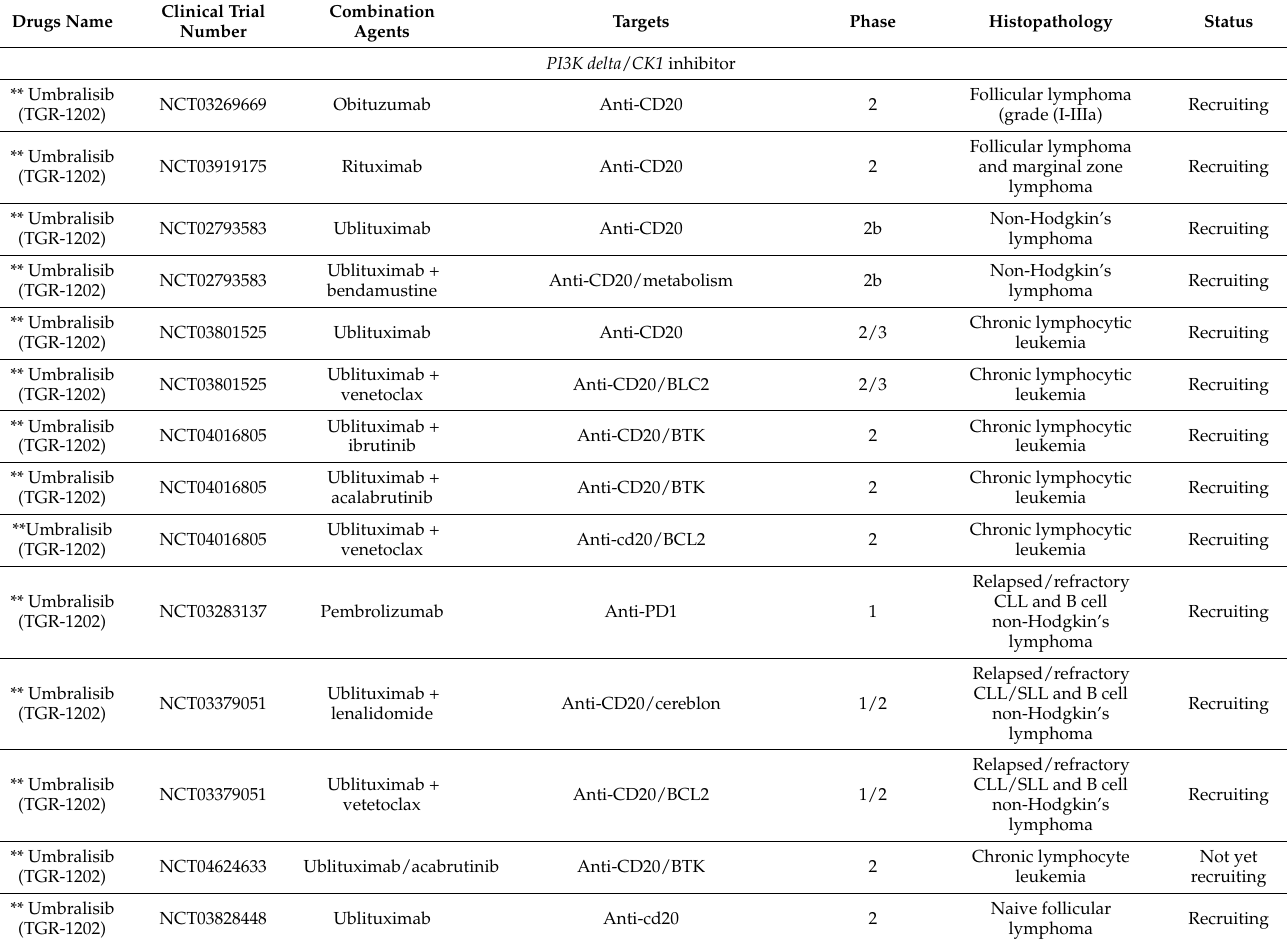
Table 1. Classification of immunomodulatory inhibitors used in clinical